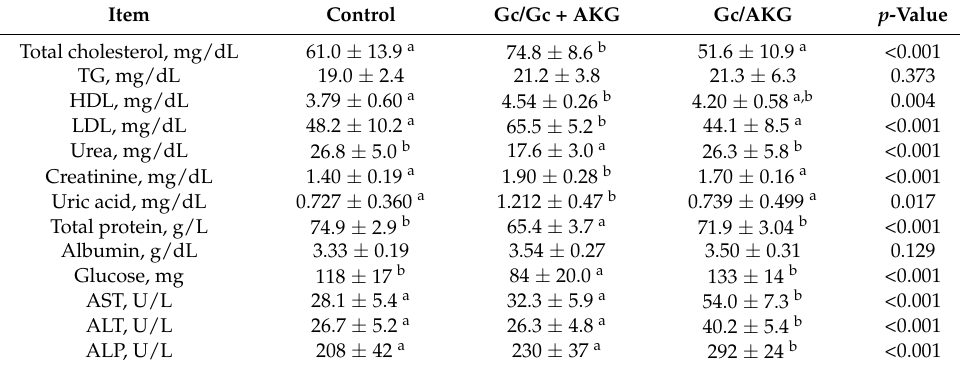
Table 5. Basal biochemical parameters in the blood serum of 35-day-old piglets.